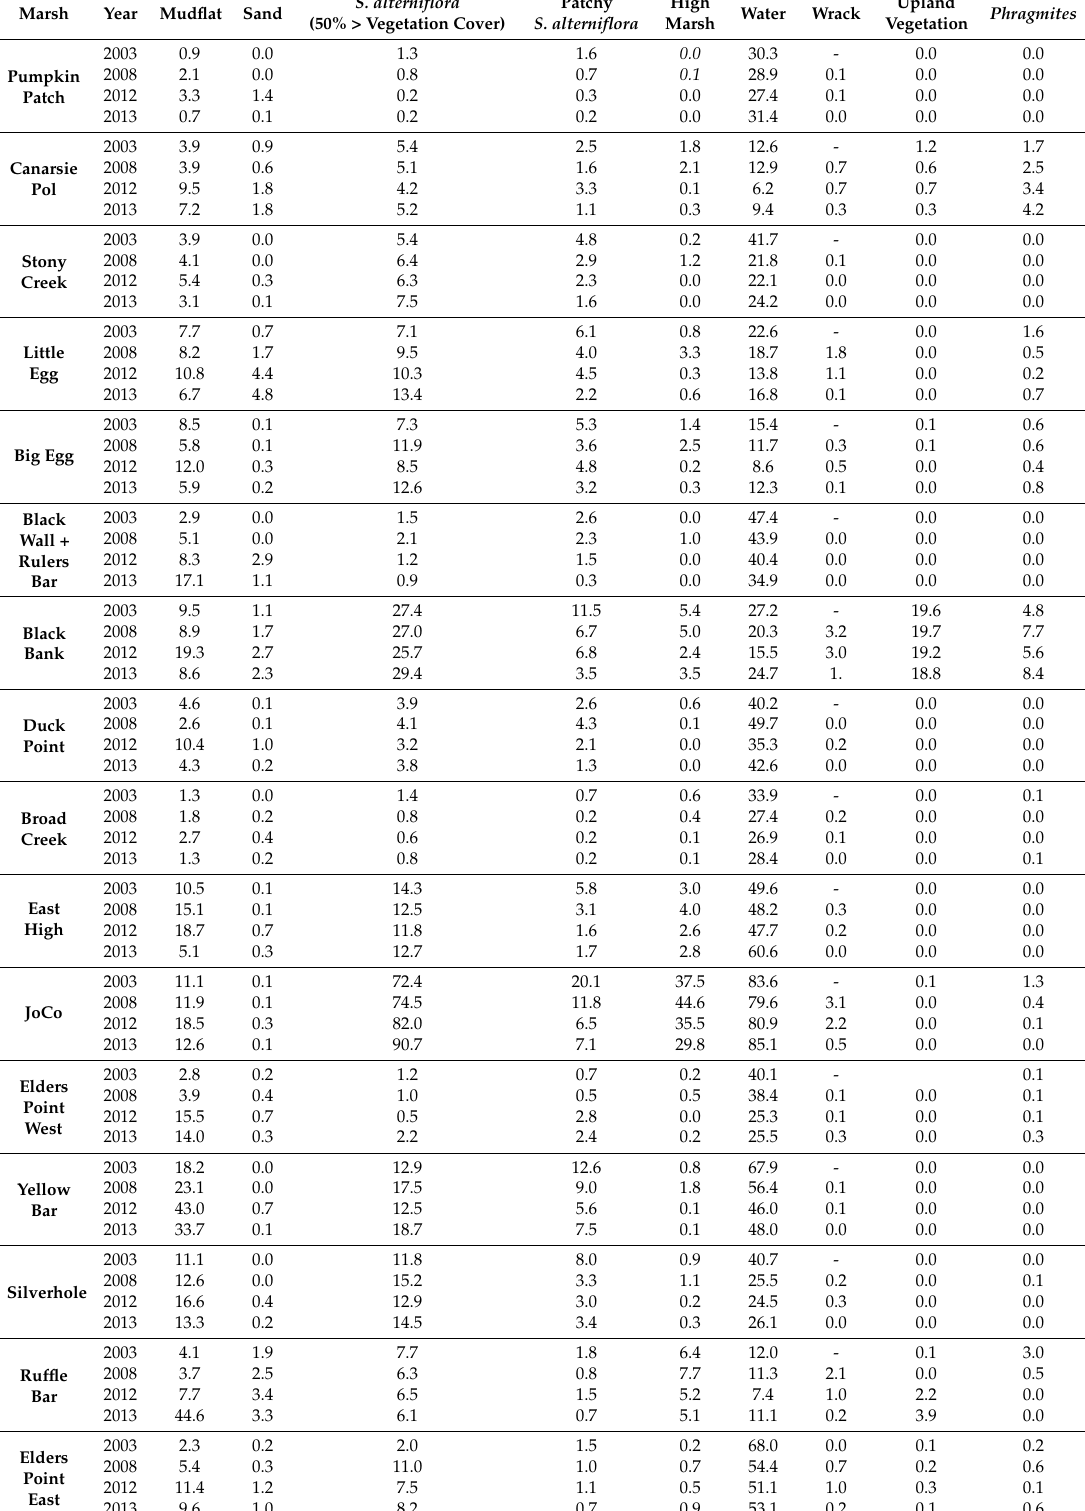
Table A1. Land cover extent of salt marsh islands